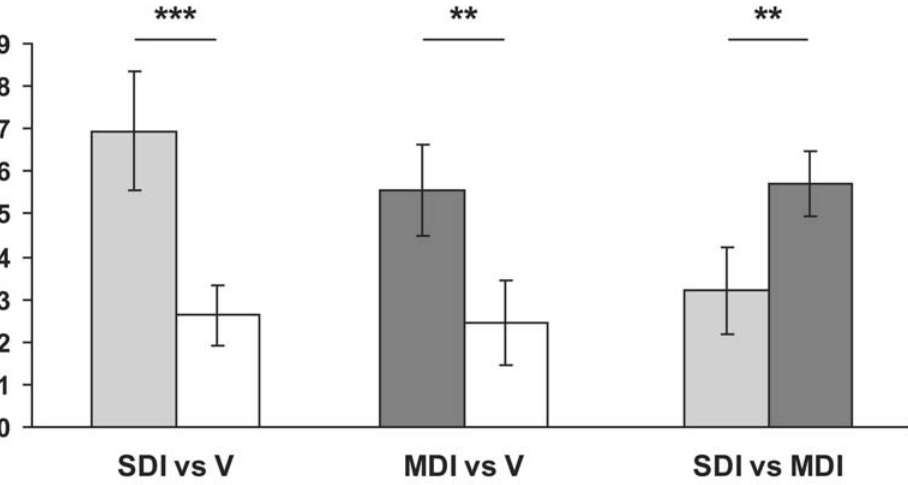
Figure 2. Workers are more attracted to the mandibular gland extracts of MDI than SDI queens. Caged workers were exposed to mandibular gland extract of two different queens simultaneously, and the retinue response to each extract was monitored. Workers were significantly more attracted to the extracts of inseminated versus virgin queens, and significantly more attracted to the extracts of MDI versus SDI queens (0.05 queen equivalents: Virgin vs SDI queens (n=19); Virgin vs MDI (n=20). MDI vs SDI (n=21); all comparison with t-test: t , 2.7, p , 0.01). ** p , 0.01 and *** p , 0.001